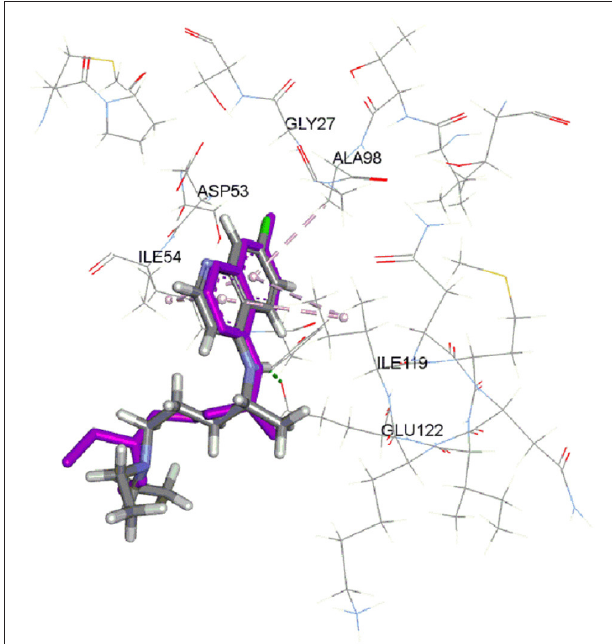
FIGURE 2 | Docked chloroquine in the binding pocket of LDH enzyme. (Purple color is crystal structure pose of chloroquine from pdb ID: 1CET).